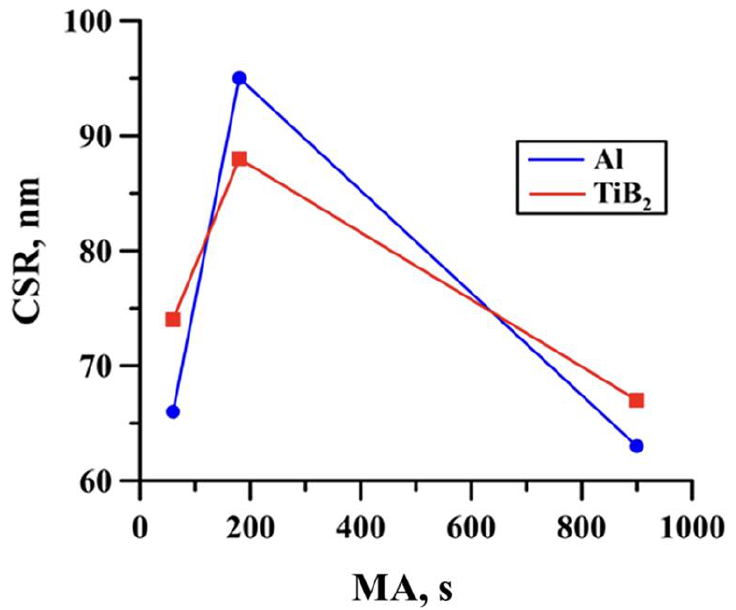
Figure 6. Dependence of the CSR size of the Al and TiB 2 phases in the SHS products on the mechanical activation duration of the initial Al-Ti-B powder mixture.